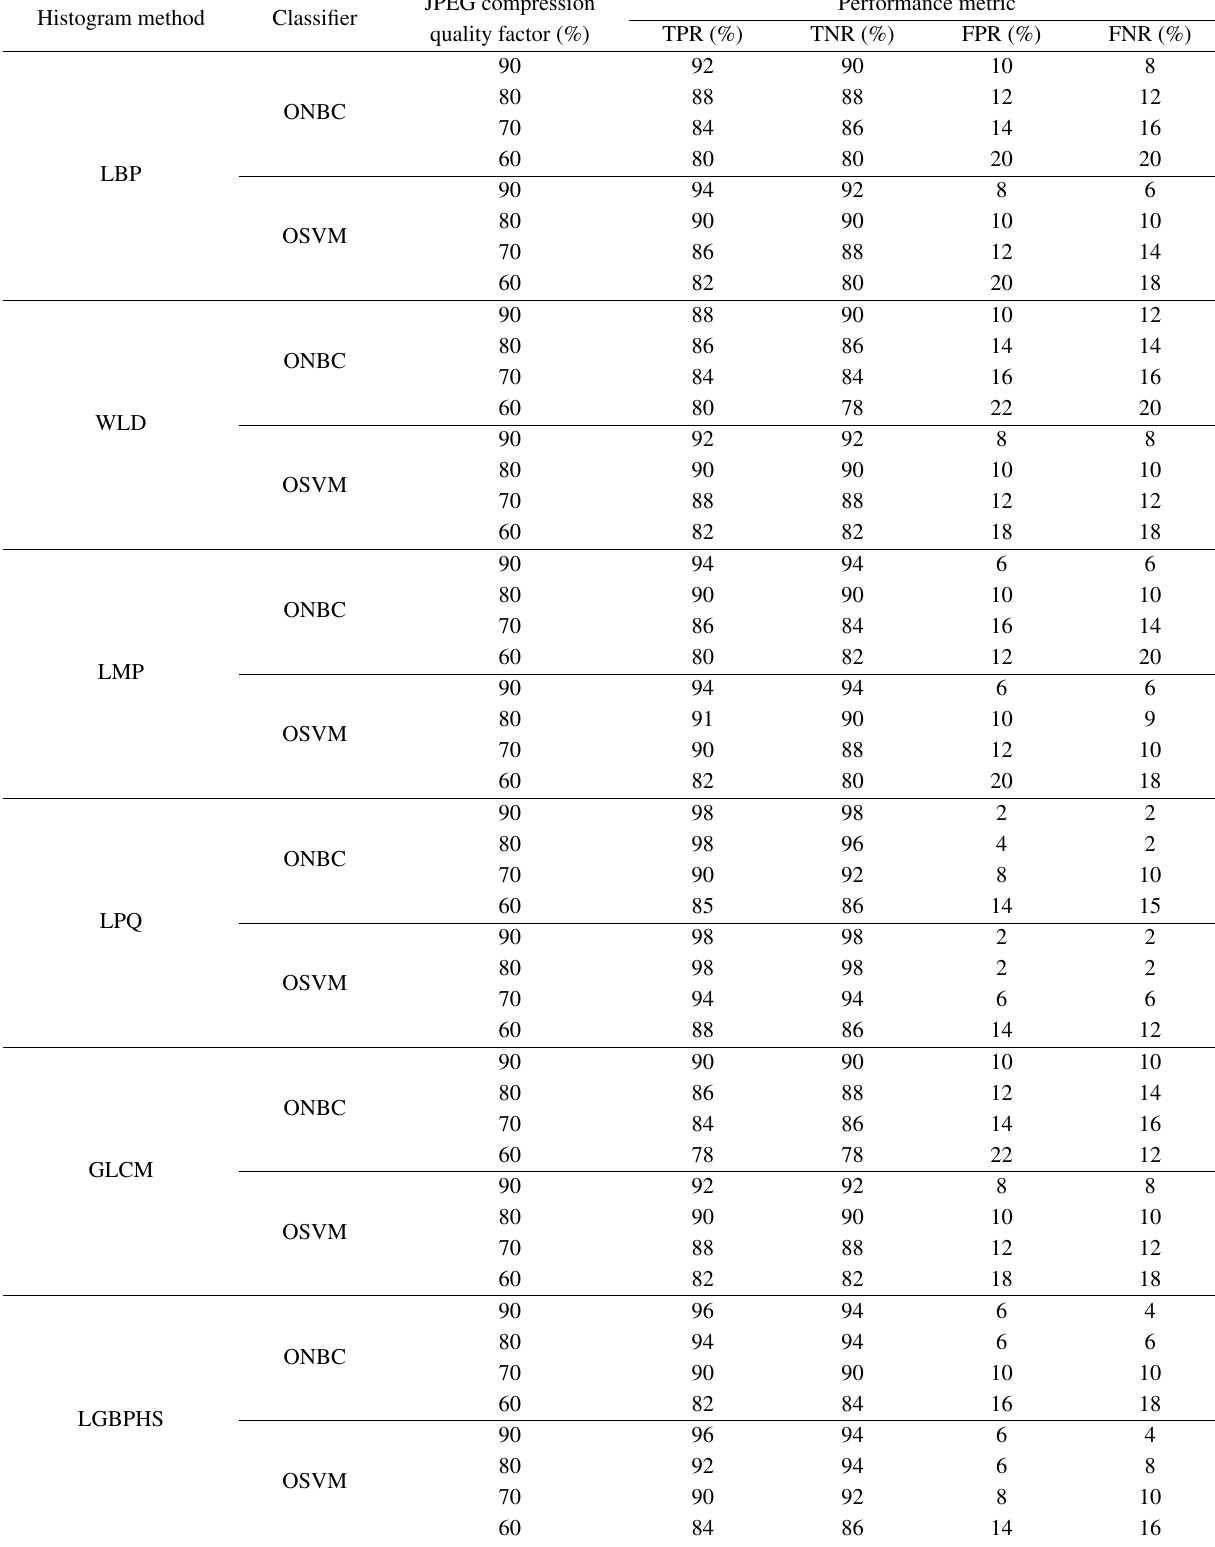
Table 5 Performance of the proposed CMFD algorithms on post-processing attack of JPEG